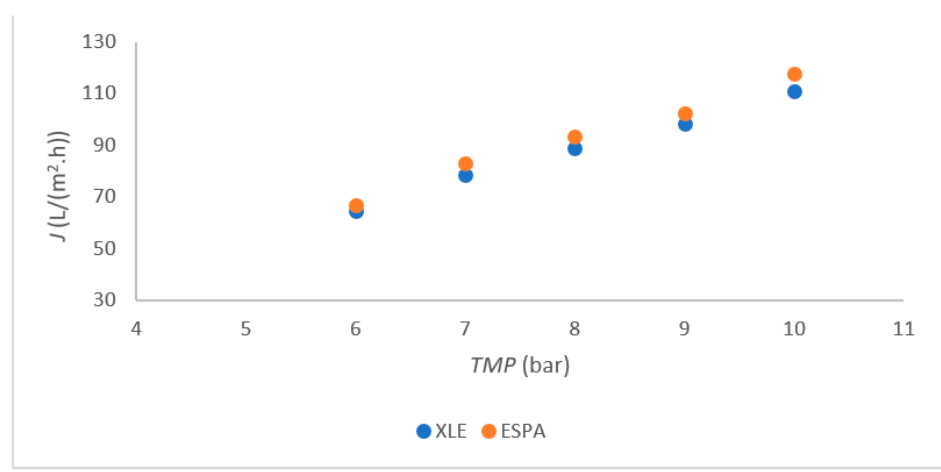
Figure 2. Flux in dependence of TMP for both membranes.